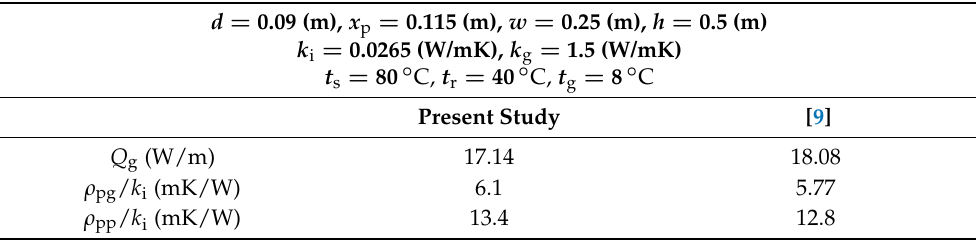
Table 4. Comparison of the present solutions with the numerical data of Bøhm and Kristjansson [9] for a buried pre-insulated double-pipe system.